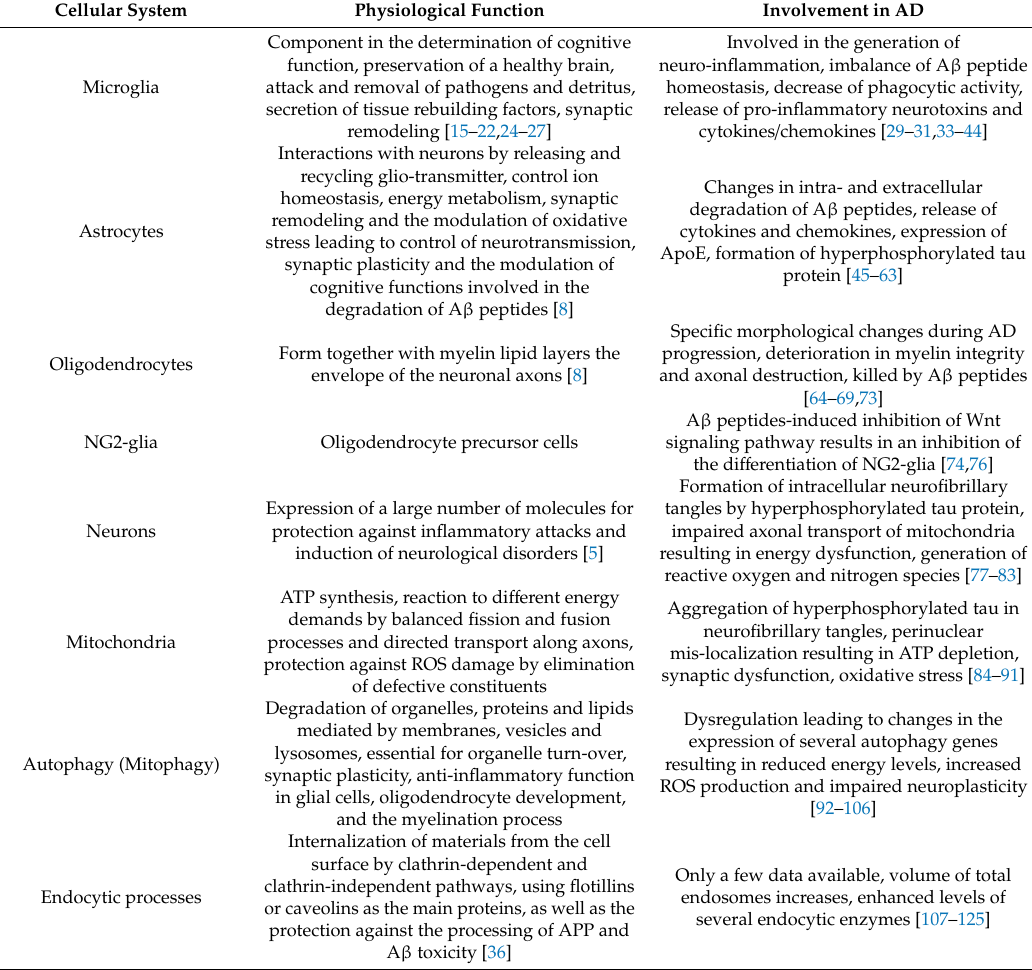
Table 1. Involvement of specific cell types and the role of organelles / cell processes in the development of